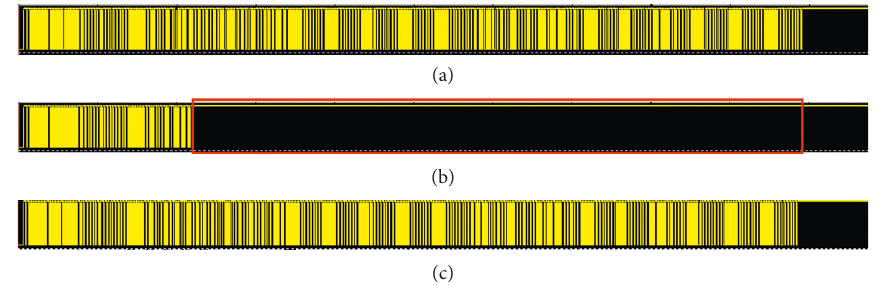
Figure 6: IR signals for remote controllers of (a) HITACHI air conditioner, (b) recordable URC, and (c) our implemented IoT home gateway.